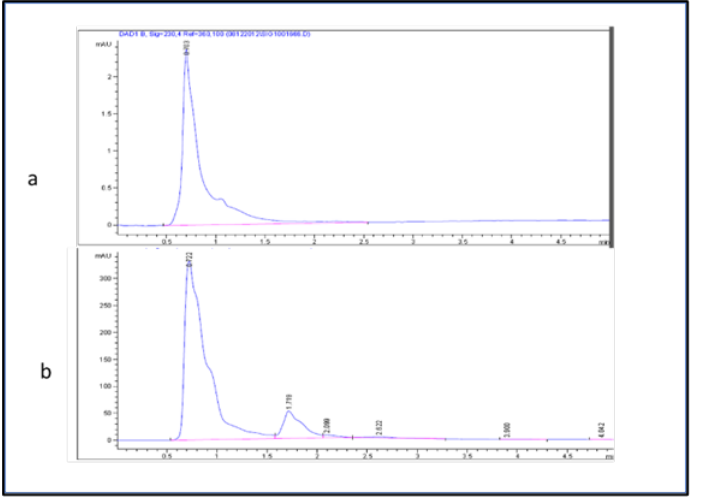
Figure 2. HPLC chromatogram ( a ) D-glucose standard and ( b ) glucose in fruit extracts.